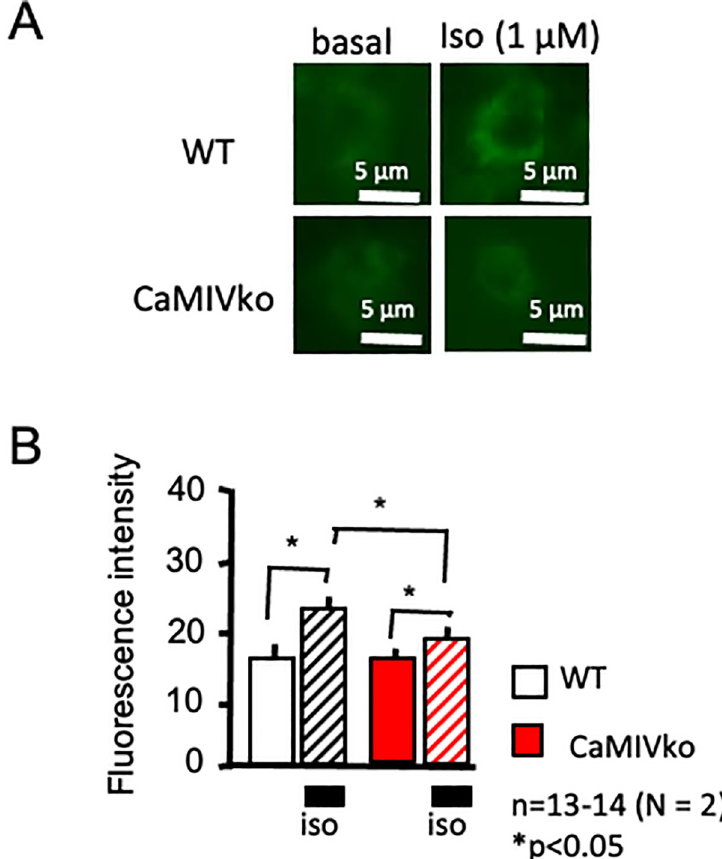
Fig 6. Expression analysis using a CREB-EGFP assay. A) Representative CREB-EGFP fluorescence. In wild-type cardiac myocytes, isoproterenol showed increased fluorescence, indicating increased cAMP levels (upper panels, wild- type [WT]). CaMKIV-null (CaMKIVko) myocytes showed a limited response (lower panels). B) Statistical analysis revealed increased CREB-EGFP fluorescence in the wild-type myocytes (open and hatched bars), whereas limited changes were observed in CaMKIV-null myocytes (red and red-hatched bars). CREB-EGFP activity was assessed according to the level of GFP fluorescence at 48 h after transfection ( n = 13–14). The results are presented as the means ± SEM. � P < 0.05. Scale bar = 5 μ